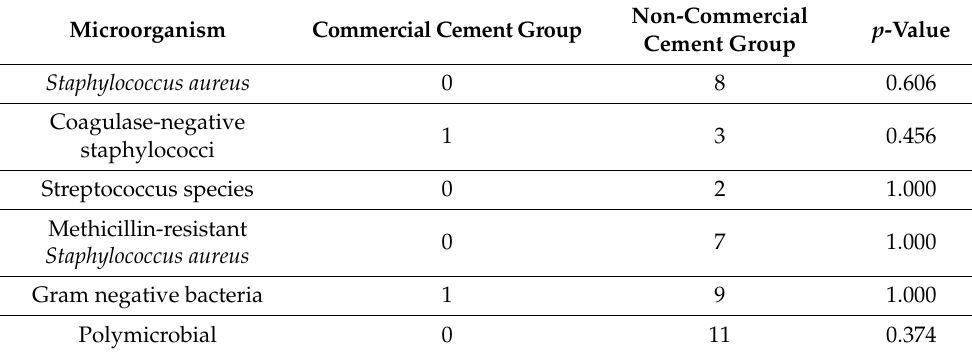
Figure 3. The reinfection rate after reimplantation between the hips and knees. Table 3. Microorganism profile at the spacer exchange between the